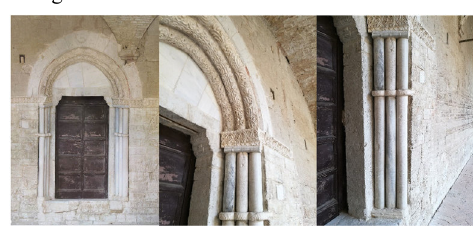
Figure 2. The portal in the cloister of the Duomo Vecchio